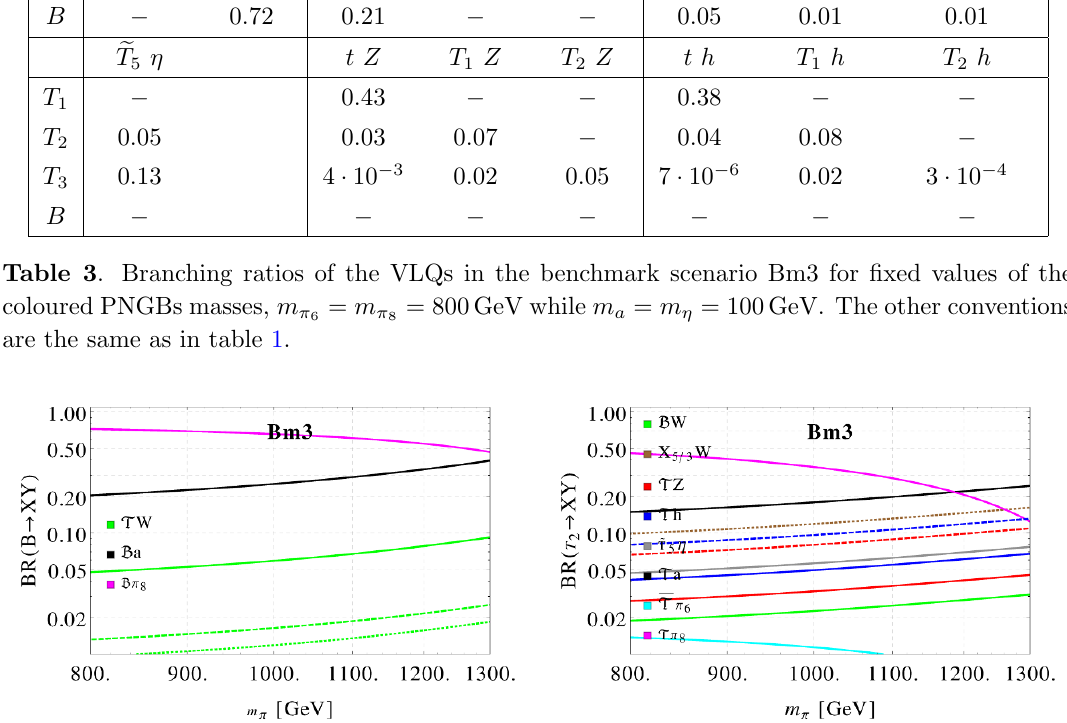
Figure 8 . Branching ratios of B and T 2 as a function of the mass of the coloured pNGBs, m (cid:25) = m (cid:25) = m (cid:25) , for the benchmark model Bm3 detailed in the text. The continuous, dashed and dotted 6 8 lines correspond respectively to T = f t; T 1 ; T 2 g or B = f b; B g